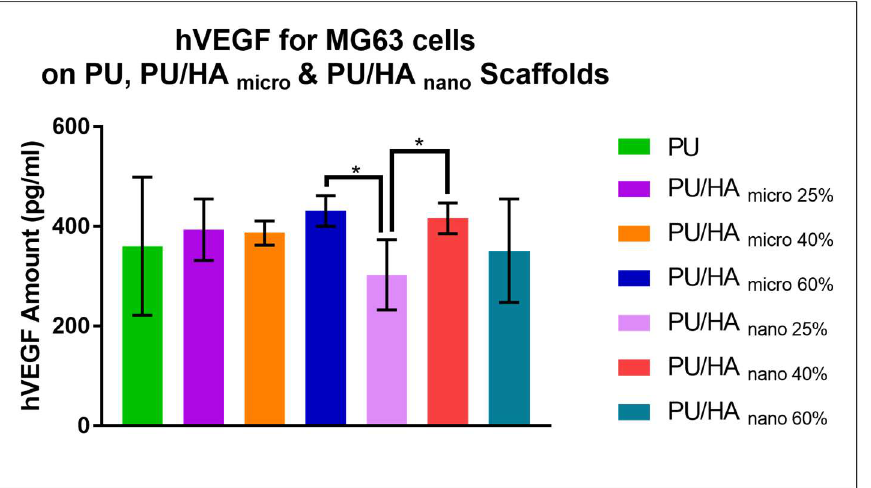
Figure 12. the VEGF protein amount was similar between PU, PU/HA micro and PU/HA nano scaffolds with no significant difference. Except on the PU/HA nano 25% , as it was significantly lower than PU/HA micro 60% and PU/HA nano 40% . Differences between two groups were distinguished as statistically significant if p ≤ 0.05 (*).